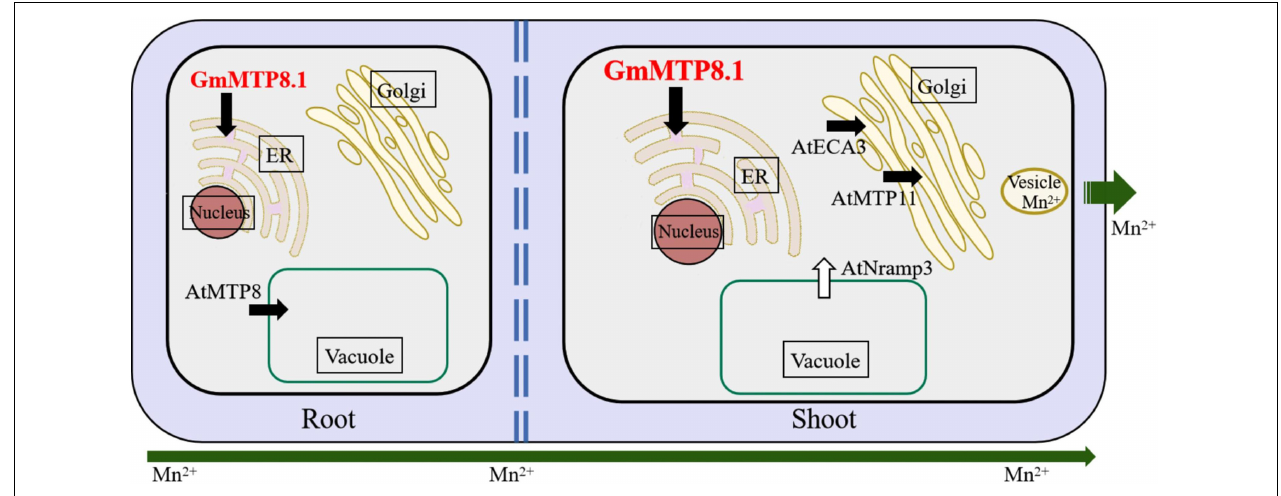
FIGURE 10 | Hypothetical view of GmMTP8.1 affecting Mn tolerance in transgenic Arabidopsis. Endoplasmic reticulum (ER)-localized GmMTP8.1 is involved in Mn transport into the ER, which has probably contributed in reduction of cytosolic Mn and maintenance of Mn homeostasis in transgenic Arabidopsis overexpressing GmMTP8.1 . Furthermore, cytosolic Mn in leaf can be transported into the Golgi apparatus by the involvement of Golgi-localized AtMTP11 and ECA3, and then sequestered into vesicles and removed from the cell via exocytosis, thereby decreasing cellular Mn levels in shoot. The upregulation of AtNRAMP3 might also help to maintain Mn homeostasis in leaves of transgenic Arabidopsis. In addition, GmMTP8.1 has likely mediated Mn tolerance, along with AtMTP8, by increasing Mn sequestration into root vacuoles, conferring Mn tolerance. White and black arrows represent import into and export out of the cytosol,